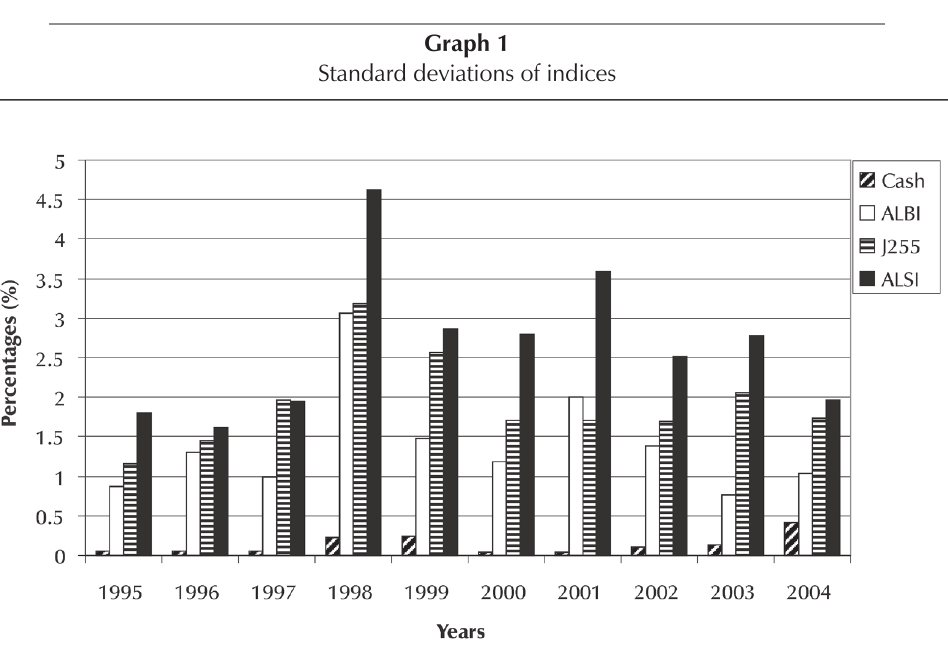
indices, as well as correlation coefficients and